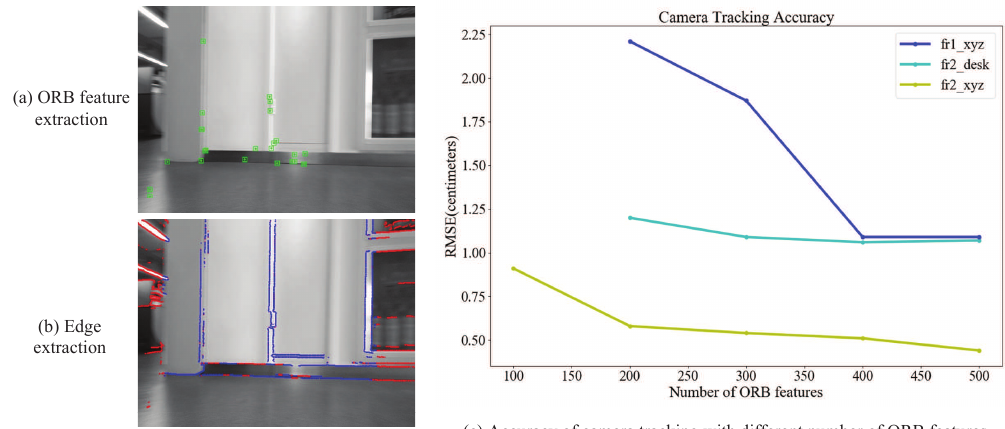
Figure 2. ( a , b ) Comparison of ORBfeature extraction and edge extraction on an RGB image. Green denotes the ORB feature points; blue denotes edges with low uncertainty; red denotes edges with high uncertainty. ( c ) Variations of the camera tracking accuracy (Absolute Trajectory (ATE) RMSE in centimeters) with different numbers of ORB features extracted per